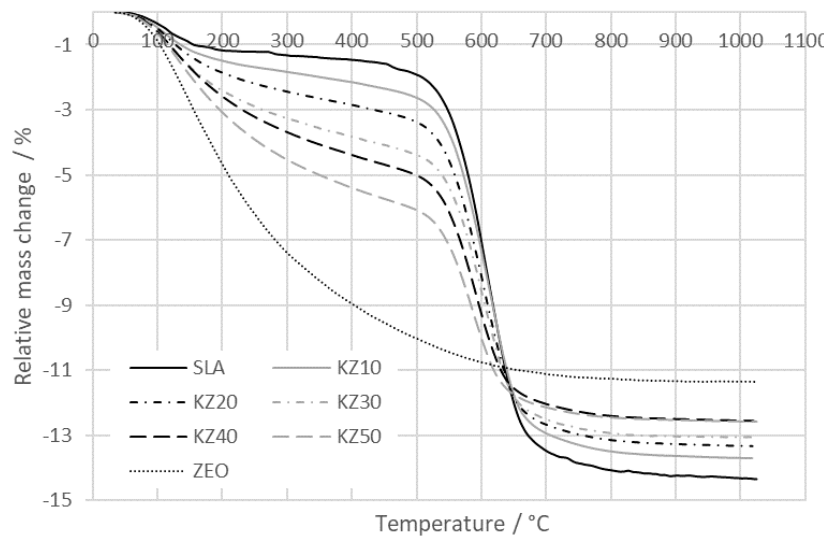
Figure 4. Relative mass change of the studied samples.